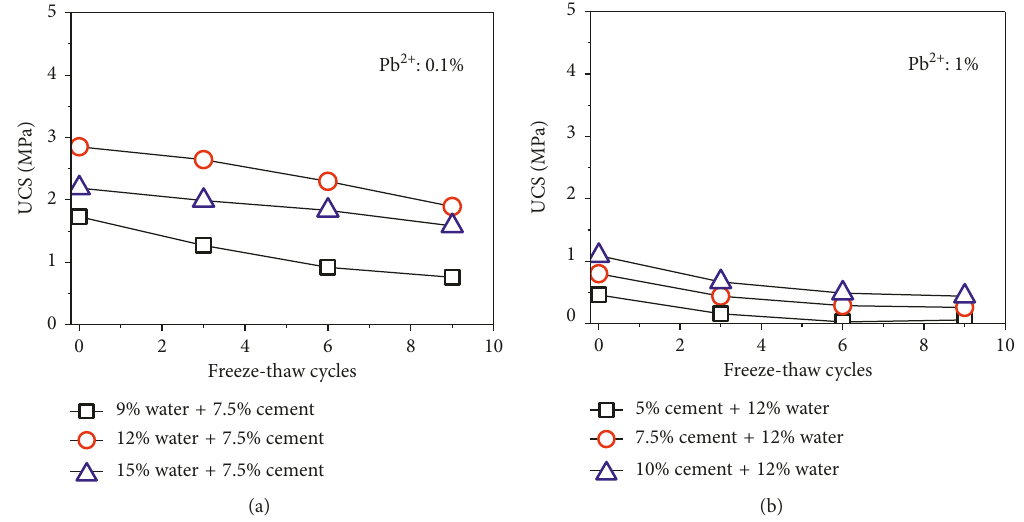
Figure 2: UCS of unreinforced samples during freeze-thaw cycles. (a) Various percentages of water content based on 7.5% cement+0.1% Pb(II). (b) Various percentages of cement content based on 12% water+1% Pb(II).